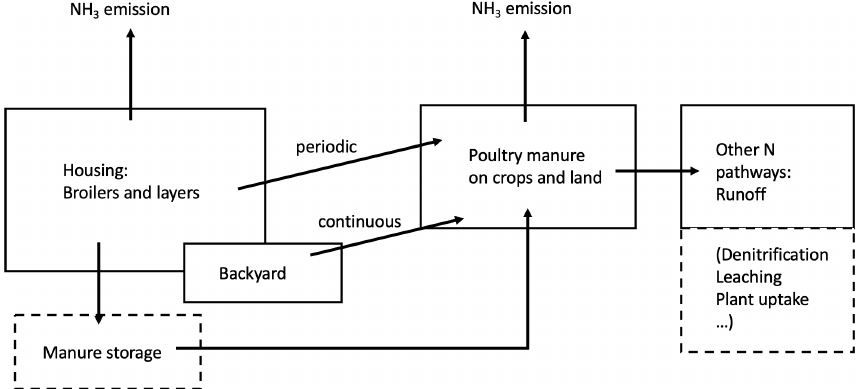
Figure 1. Schematic of the AMCLIM–Poultry model for estimating NH 3 emissions from global chicken farming, following nitrogen path- ways from chicken farms to land spreading. Arrows represent the nitrogen flows from chicken farming. Aspects noted in dashed boxes are not investigated in this study.